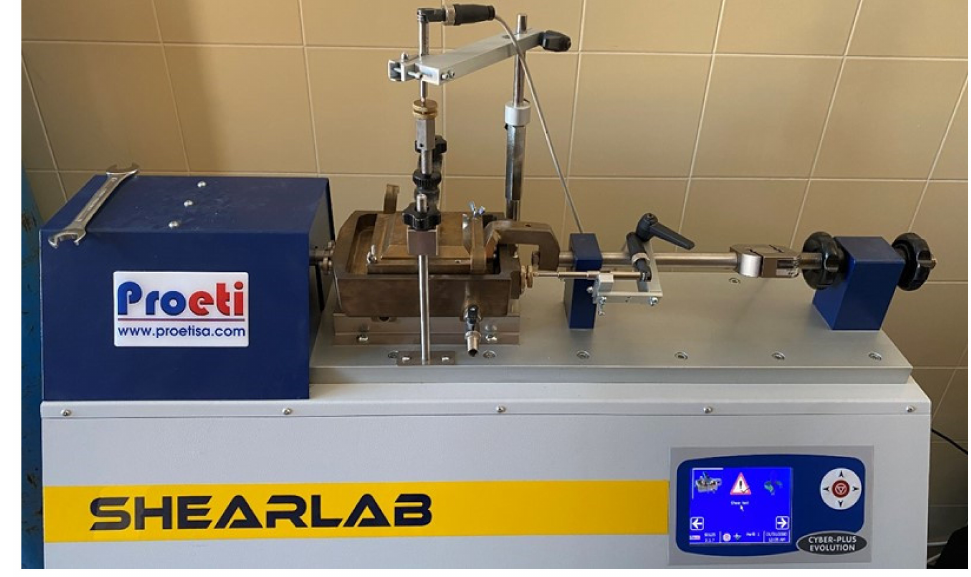
Figure 2. Semi-automatic direct shear test